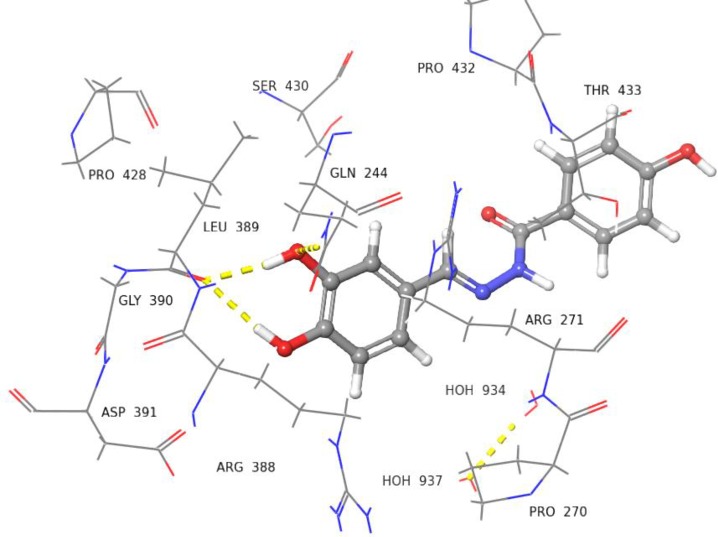
3D Representation of docked pose of compound 3 (IC50 = 229.5 ± 2.1 μM).The two OH groups showed H-bonding with Leu389 and Gln244 (yellow dotted lines).